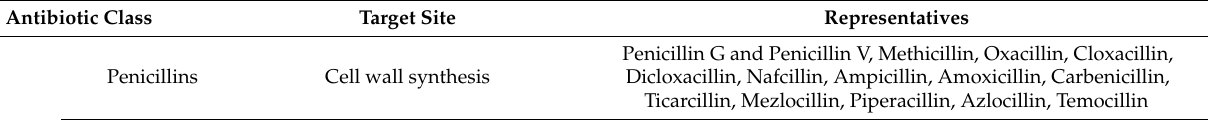
Table 1. Antibiotics’ classification by the mechanism of